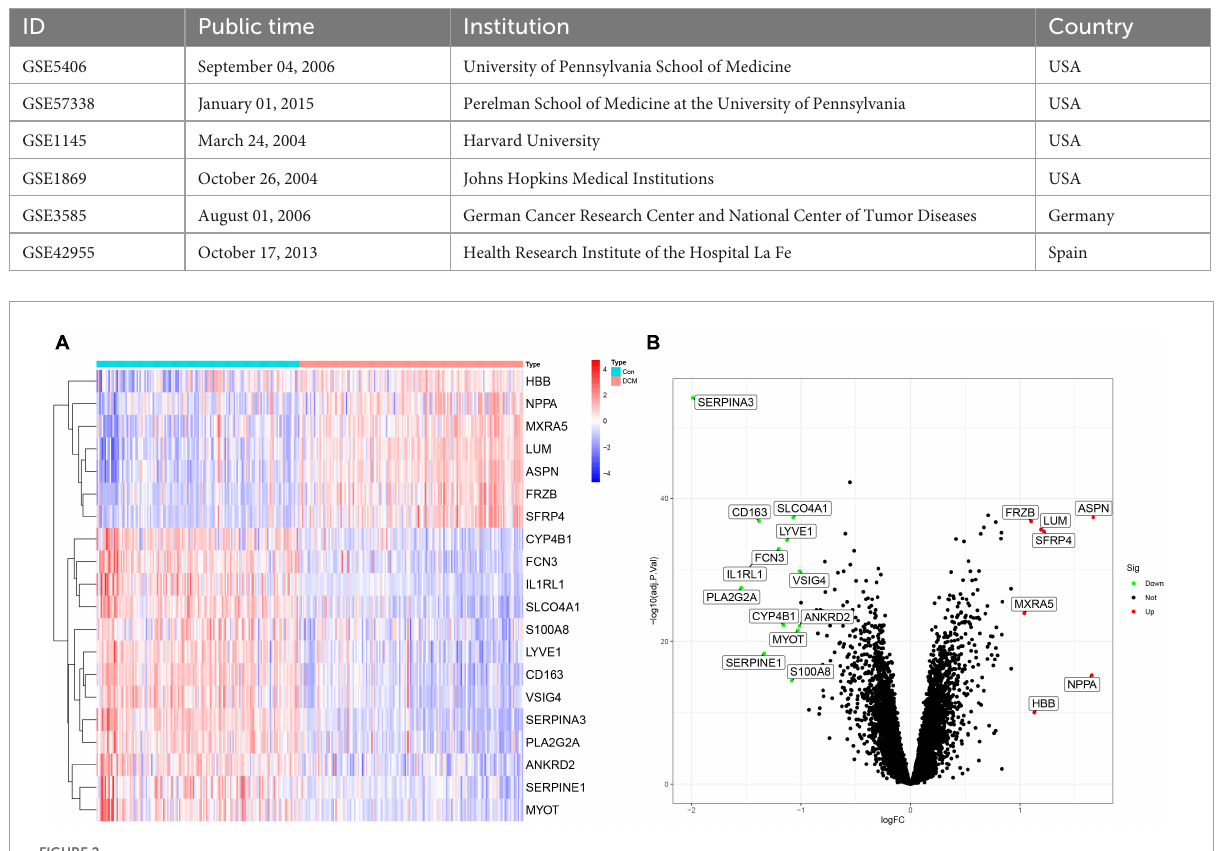
FIGURE2 The heatmap and volcano plot of 20 differently expressed genes (DEGs) in dilated cardiomyopathy (DCM) and healthy. (A) The heatmap of 20 DEGs; (B) the volcano plot of 20